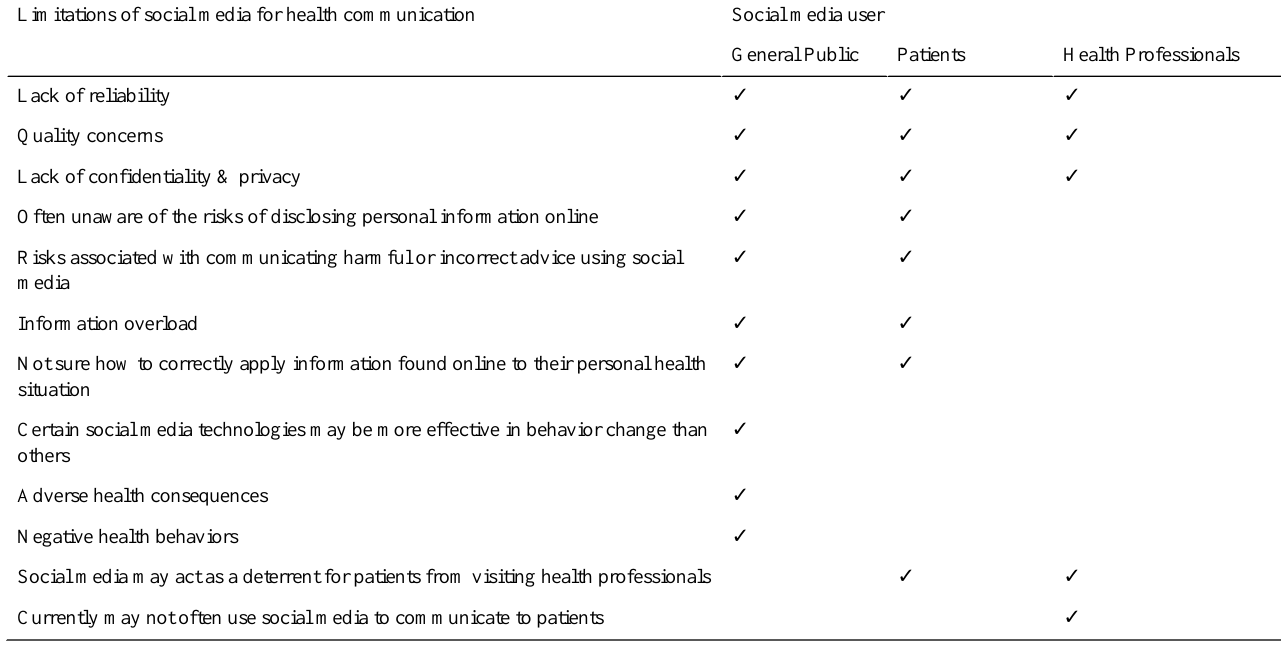
Table 5. Limitations of social media for health communication among the general public, patients, and health